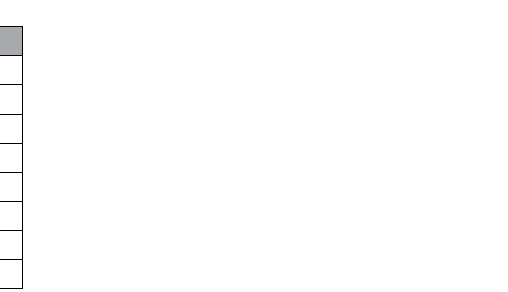
Table 5. DSTs’ size and weight by age (n juveniles = 416; n adults/ subadults = 379).